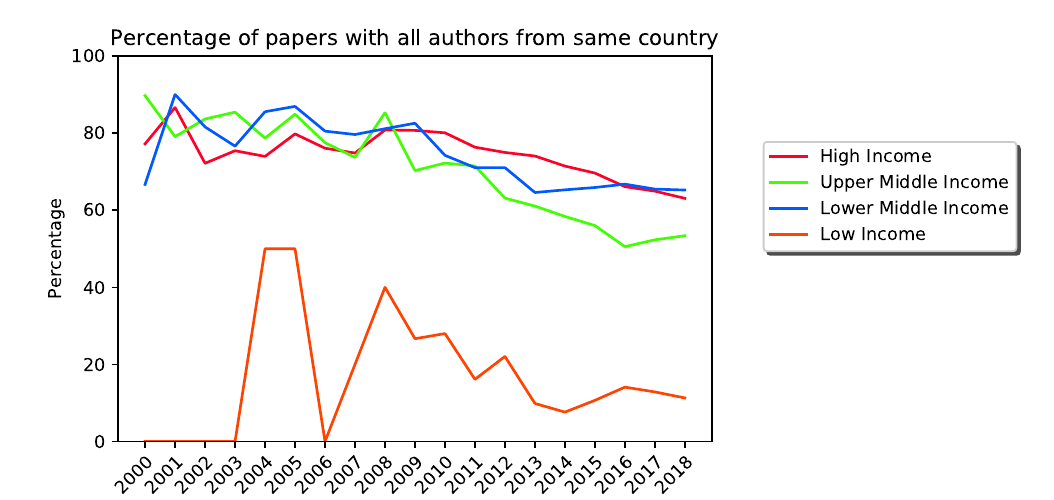
Figure 2. This shows income group level time series for the percentage of papers published with only a single country represented. As can be seen, all income groups have experienced increased international collaboration between 2000 and